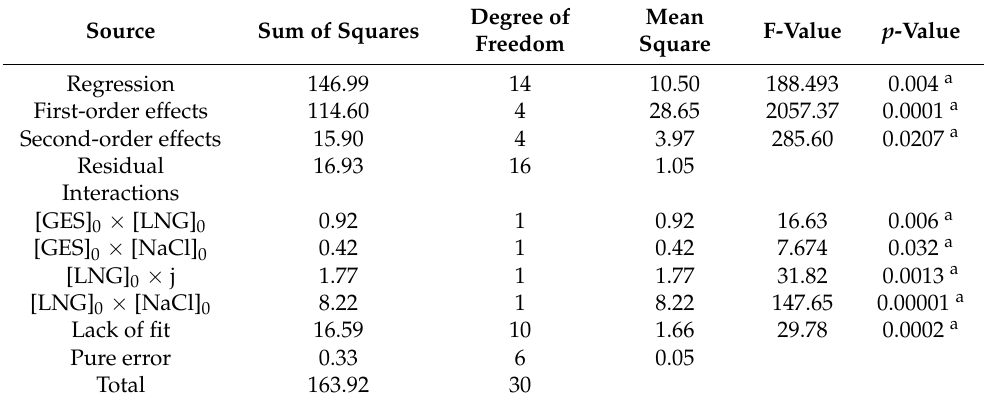
Degree of Mean F-Value p -Value Freedom Square